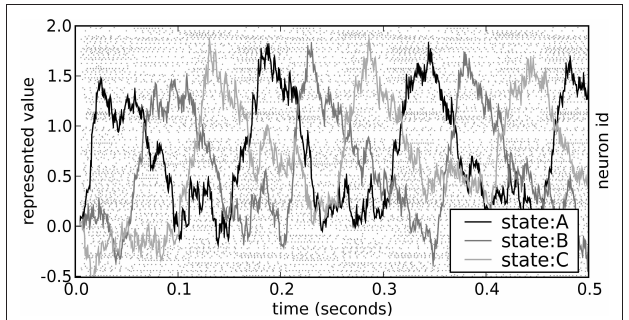
FIGURE 6 | Spike pattern and vector decoding of a neural population implementing an ACT-R goal buffer. Dots indicate spike times for each neuron in the goal buffer, arranged along the y -axis. The three lines show the three-dimensional value decoded from the spikes using Eq. 3. The three dimensions correspond to the three possible values for the buffer, showing that the represented value cycles through the three